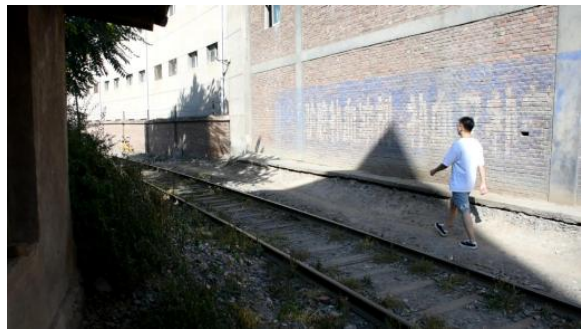
Fig. 10. The results of processing using three algorithms